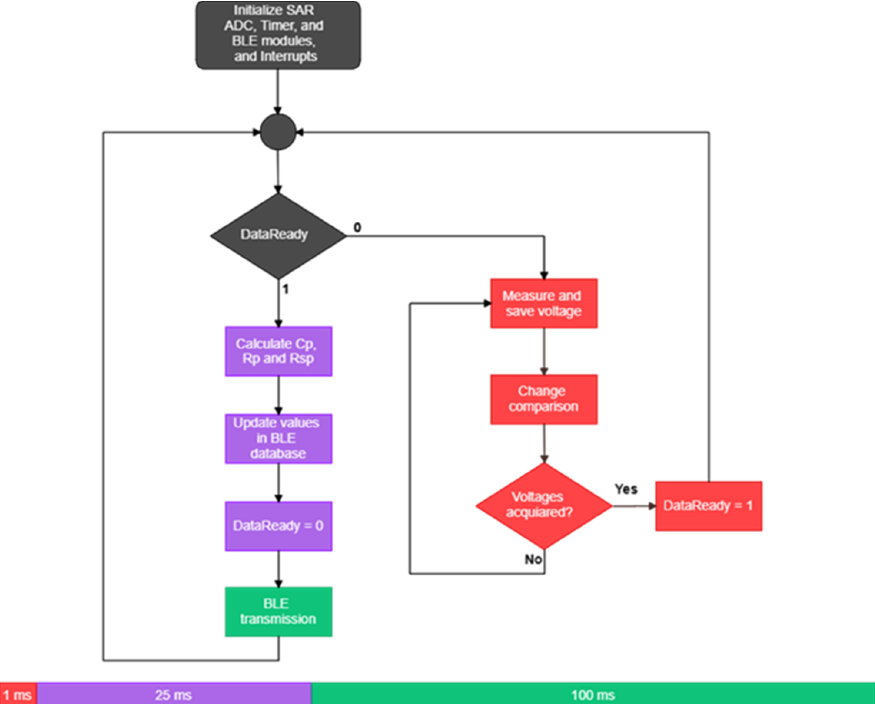
Figure 8. Flow diagram of the algorithm implemented in the PSoC module. The timeline